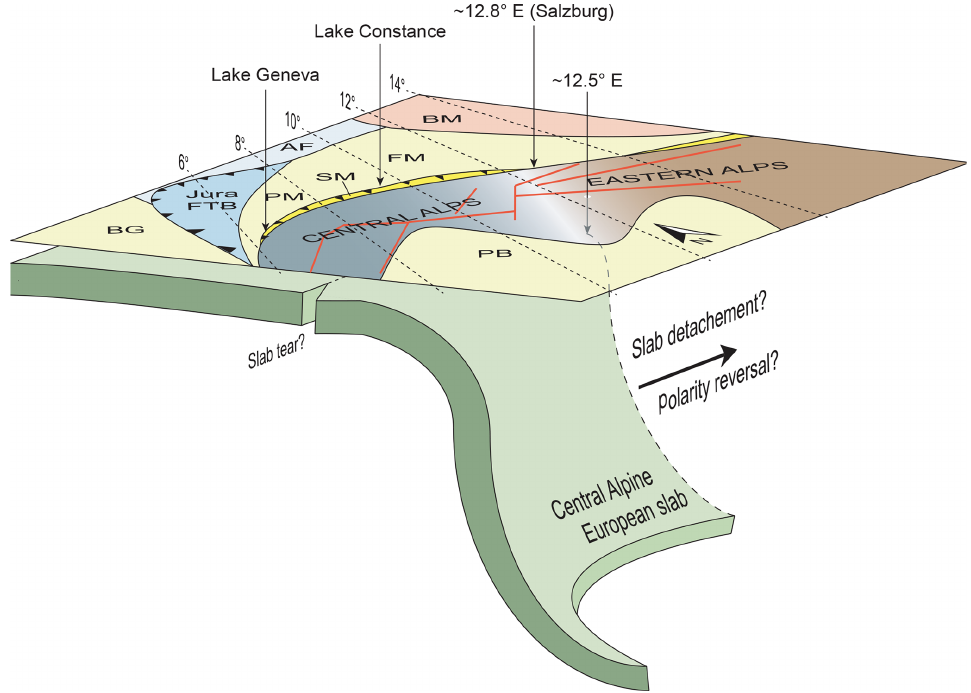
Figure 9. Schematic 3D representation of the structure of the Central Alpine European slab and its spatial correlation with the eastward termination of the late-Miocene Subalpine Molasse near Salzburg. PM, Plateau Molasse; FM, Foreland Molasse; SM, Subalpine Molasse; PB, Po Basin; TW, Tauern Window; BF, Brenner Fault; FTB, fold-and-thrust belt; BG, Bresse Graben; AF, autochthonous foreland; BM, Bohemian